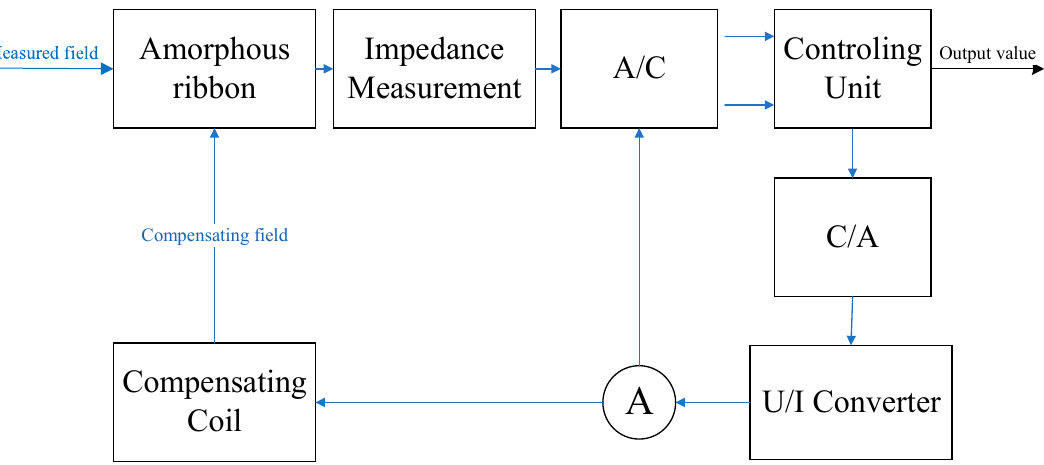
Figure 5. Block diagram of the operation of the proposed sensor.